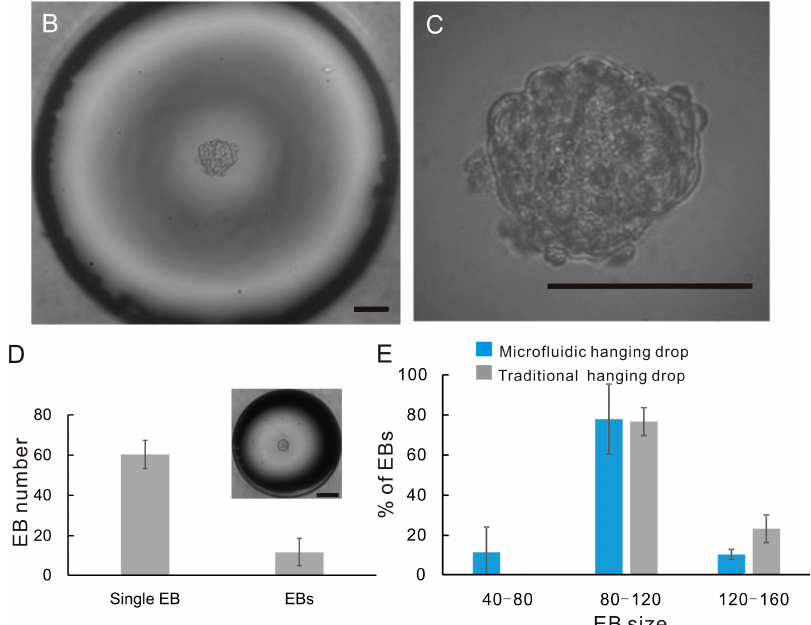
Figure 4. EB formation after 1 day. ( A ) Images of the top-view of the chip after 1 day culture; ( B , C ) The closed view of one EB; ( D ) the comparison between the number of single EB and EBs. The photo shows the satellite EBs are less than 40 μ m; ( E ) the size distribution of the EBs. Figure 5A–D shows the images of the EBs formation in four wells during three days of culture. The ES cells formed EBs which continued to be proliferated. The sizes of EBs were measured every μ HD chip and conventional system. The EBs in the μ HD system had a growth similar to that of EBs cultured by the conventional method.